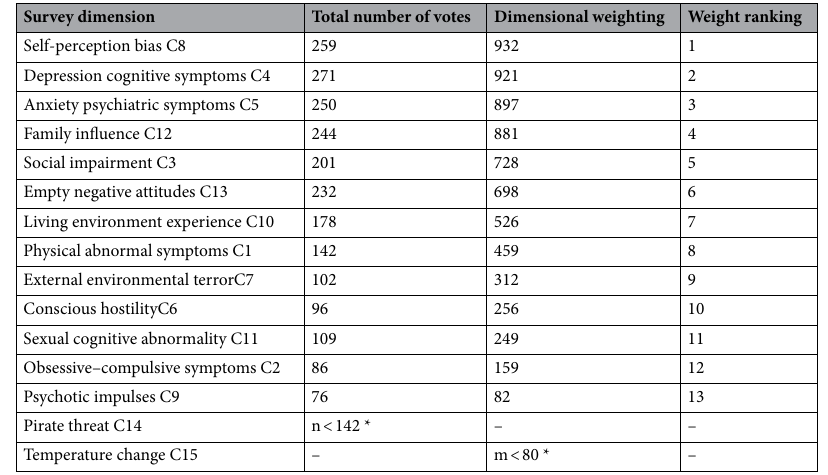
Table 1. Weighted ranking of subjective weights of survey dimensions. 1 n = 283. This statistic is based on relatively subjective results of respondents for the mental health measure dimensions, with a small bias in the ranking, and the table only shows the main influences that met the statistical criteria. When n < 142 and m <